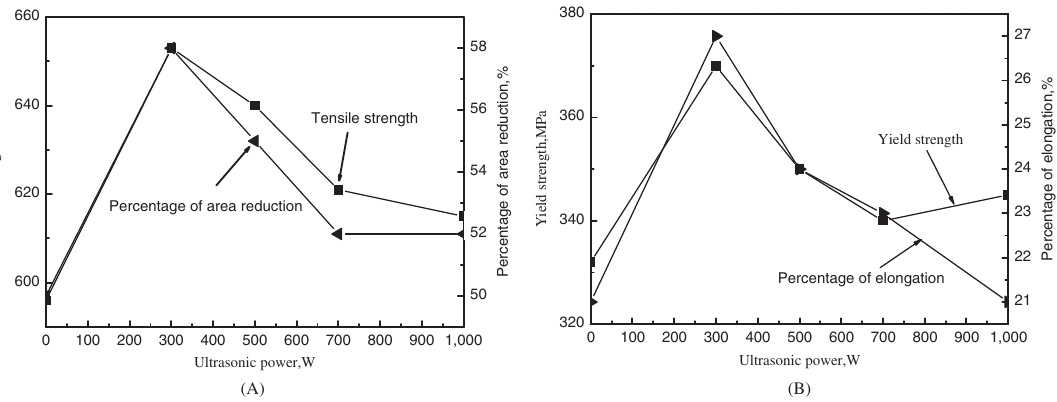
Figure 9: Mechanical properties of GCr15 steel with different ultrasonic power. (A) Tensile strength and reduction of area after ultrasonic treatment. (B) Yield strength and percentage of elongation after ultrasonic